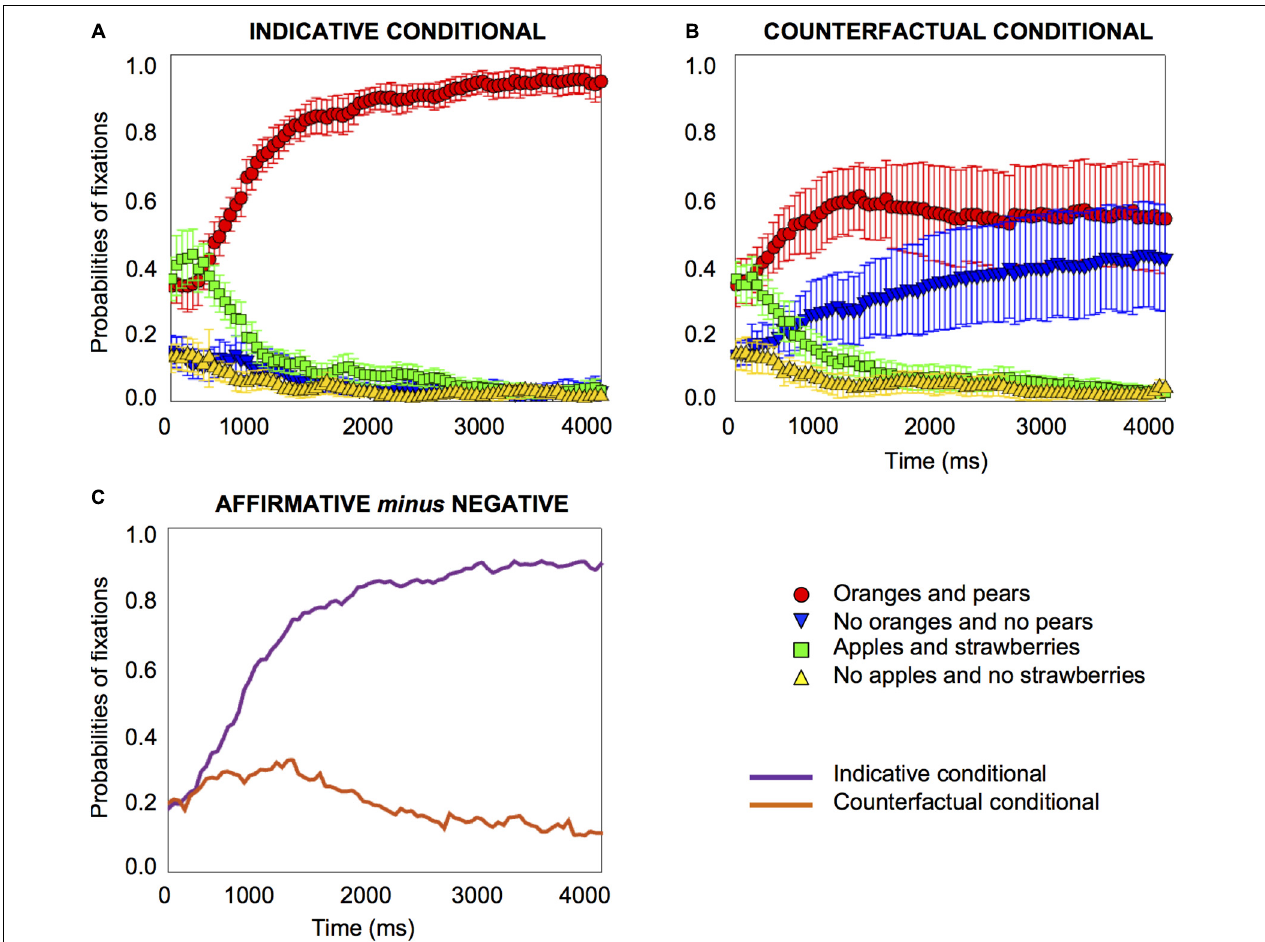
FIGURE 2 | Probabilities of fixations for indicative conditionals, e.g., “if there are oranges, then there are pears” (A) and counterfactual conditionals, e.g., “if there had been oranges, then there would have been pears” (B) in Experiment 1 on the affirmative and negative images, and the two distractor images, time-locked to the onset of the first object word, e.g., oranges. The differences in the probabilities of fixations (on the affirmative image minus the negative image) for indicative and counterfactual conditionals emerge at 850 ms , as (C) shows. Error bars are 95% confidence intervals within participants (see Morey, 2008; O’Brien and Cousineau,